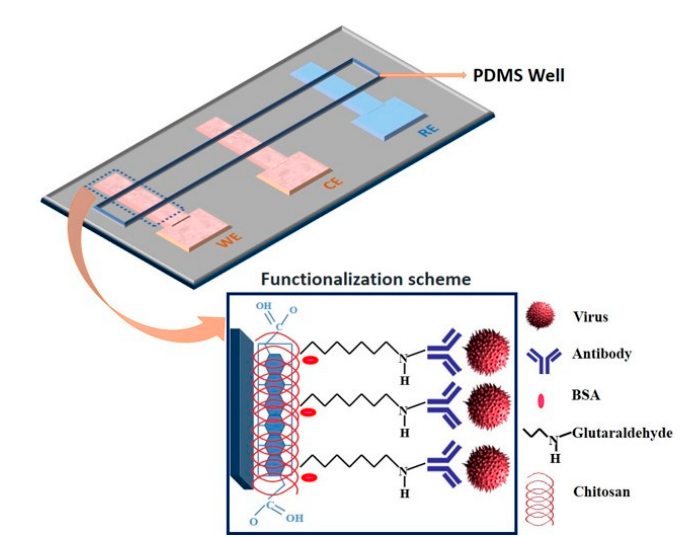
Figure 16. Paper-based immunosensor with a polydimethylsiloxane well containing the elec- trolyte